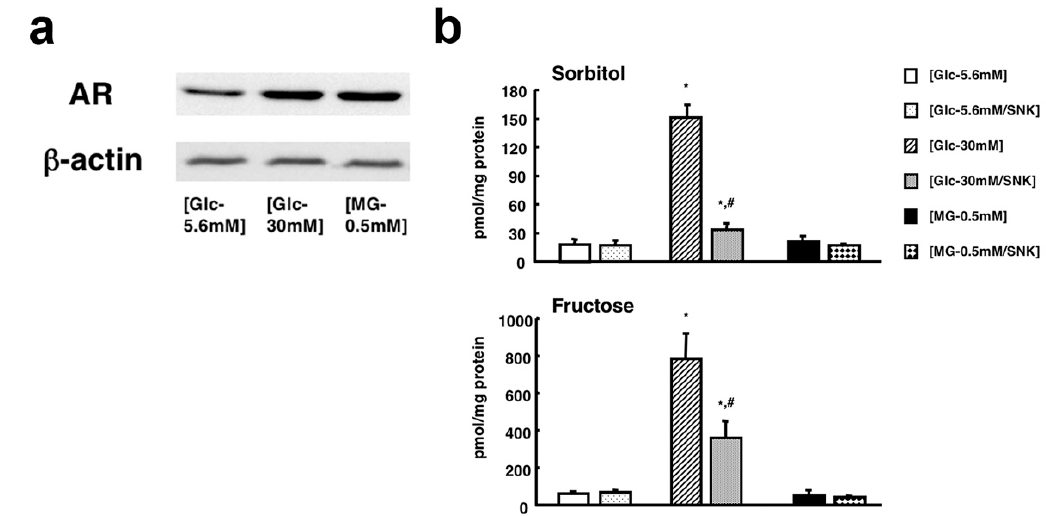
Figure 4. ( a ) High-glucose- and MG-induced upregulation of AR by Western blot analysis. ( b ) Intracellular contents of sorbitol (upper panel) and fructose (lower panel) after 7 days of exposure to (Glc-5.6mM), (Glc-30mM), and (MG-0.5mM) in the presence or absence of SNK-860 (1 µ M). Values represent the mean + SEM of 6 experiments. * p < 0.01 as compared with (Glc-5.6mM) and # p < 0.01 as compared with (Glc-30mM). Modified from Sango et al., Open Diabetes J. 2008 , 1 , 1–11 [33] (The publisher grants us the right to reuse the figure in other publications).